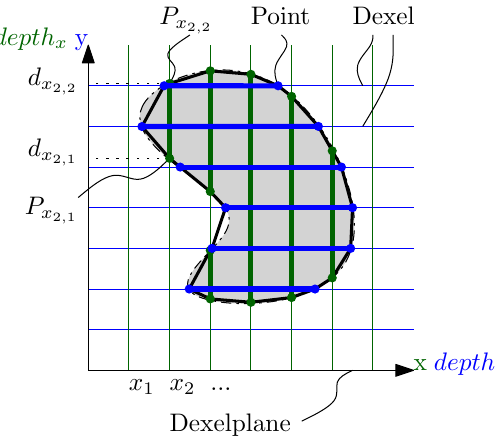
Figure 1. Multi-Dexel method in two dimensions by applying two perpendicular dexeplanes (blue and